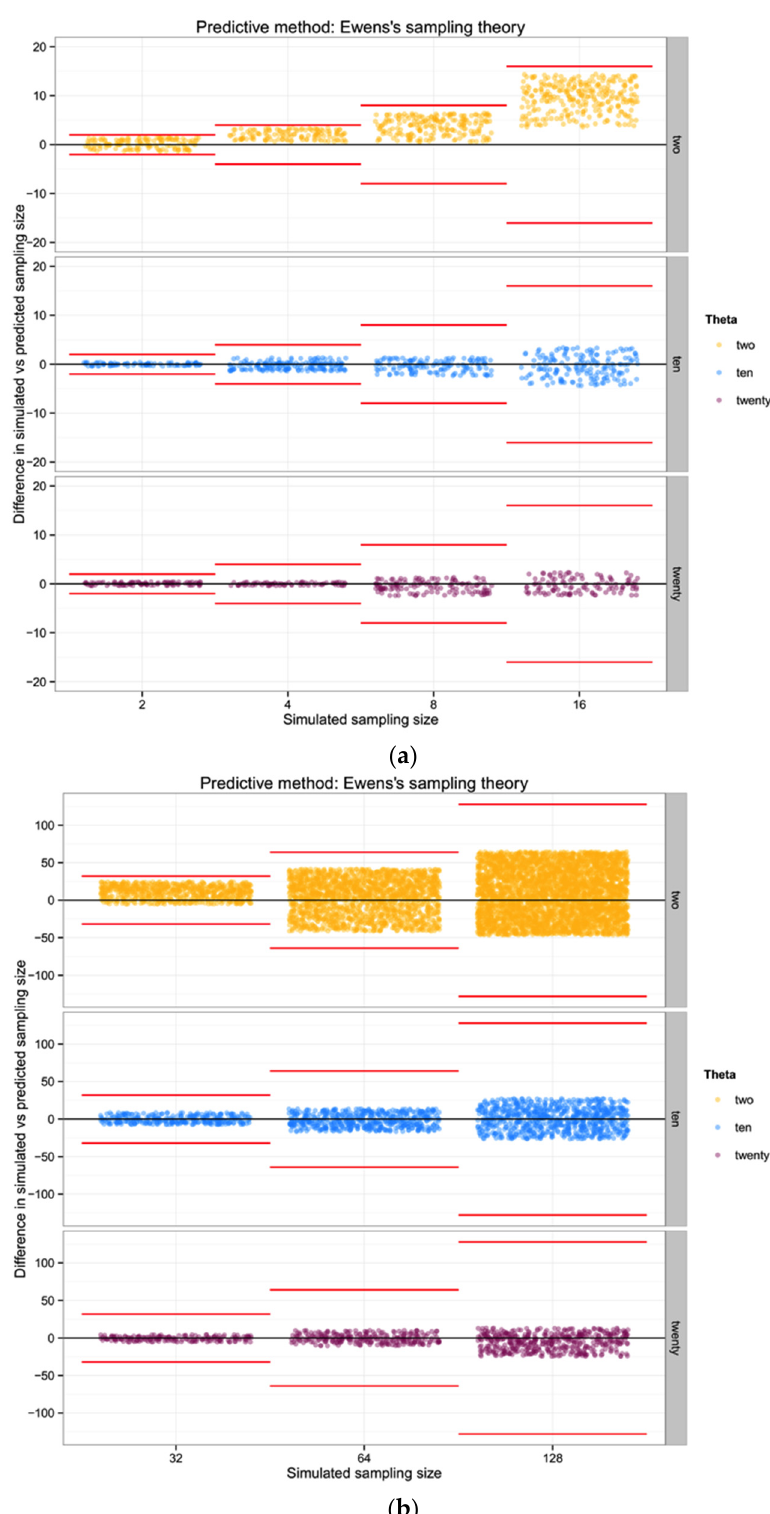
Figure 4. Difference between the simulated sampling size and the sampling size for the sample predicted using Ewens’ sampling theory. ( a ) sampling sizes of 2, 4, 8 and 16; ( b ) sampling sizes of 32, 64 and 128. The panels separate the three different values of θ : two, ten and twenty. The horizontal line at zero shows the ideal situation in which the estimation equals the simulated sampling size. The red lines show the limit where the difference between simulated and predicted equals the sampling size; that is, beyond the red lines the error is too large to make a sensible prediction. Please note that the data are jittered to enhance visualization, and that the y ‐ axis differs between ( a ) and ( b ).